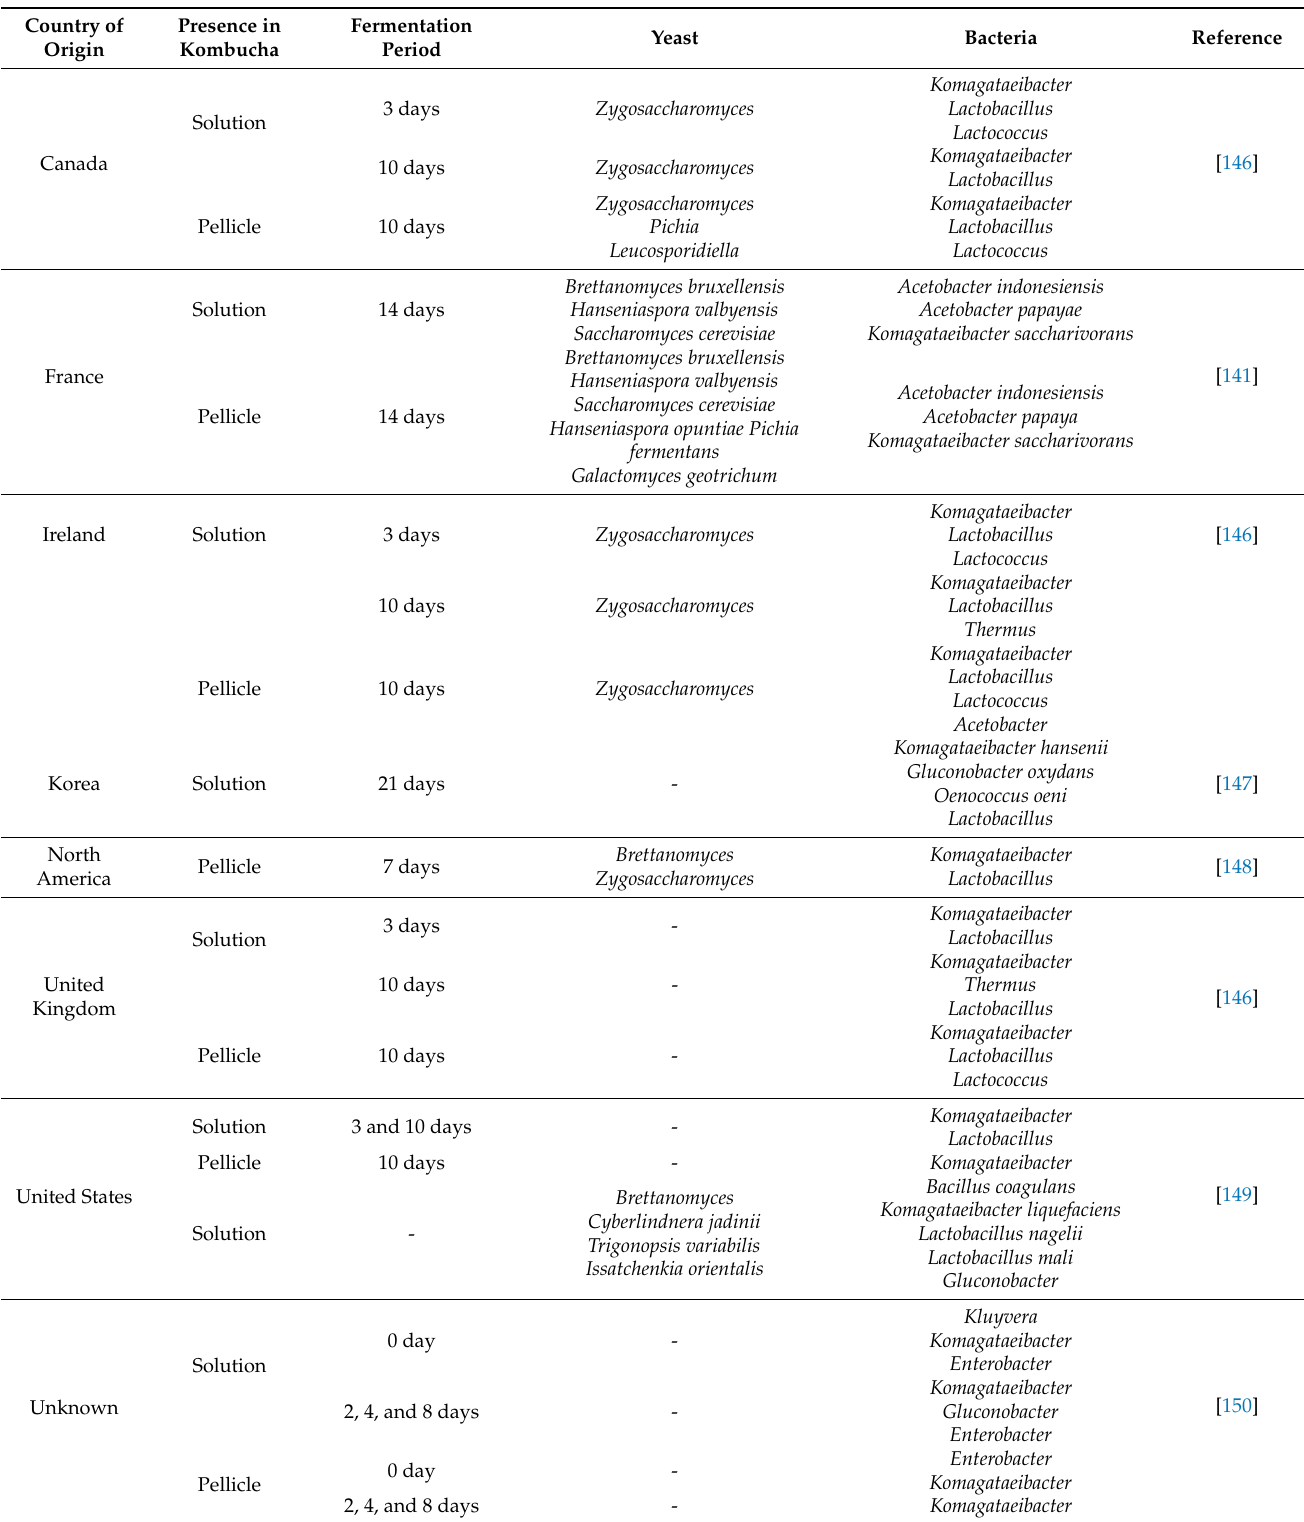
Table 2. Microbial population in